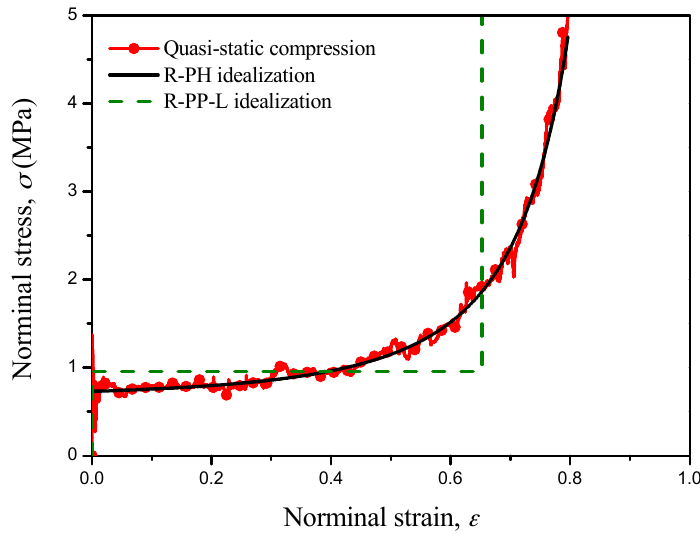
Figure 2. The quasi-static nominal stress strain curve obtained from the cell-based finite element (FE) model [31] and the R-PP-L and R-PH idealizations.